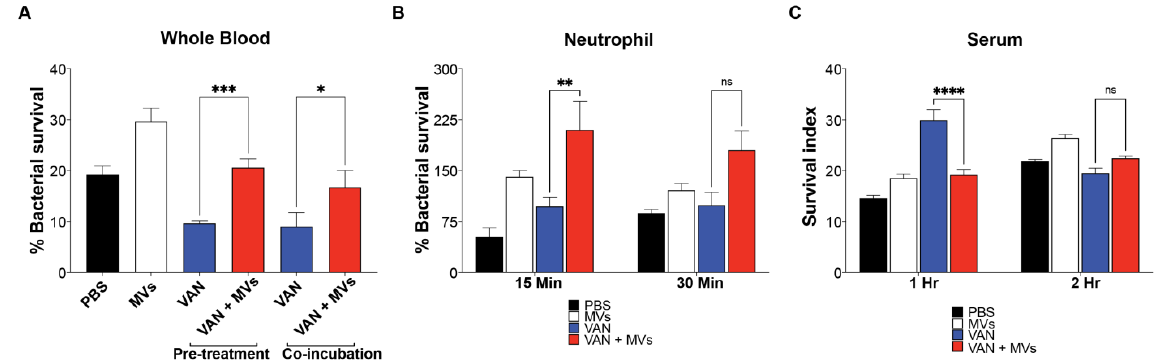
Figure 2. Ex vivo analysis of MRSA, VAN, MVs and components of host innate immunity. MRSA grown overnight or co-incubated with 0.5 mg/L of VAN are more resistant to killing by ( A ) human whole blood (3 h) and ( B ) isolated neutrophils (15 and 30 min) in the presence of MVs (20 µg). However, exogenous MVs did not significantly increase the killing of MRSA pre-treated overnight with 0.5 mg/L of VAN to ( C ) human serum complement (1 and 2 h). Data are representative of the mean ± SEM from a combination of three experiments performed in triplicate. * p < 0.05, ** p < 0.01, *** p < 0.001, **** p < 0.0001, or no statistical significance (ns) in VAN treated samples by two-way ANOVA. PBS: Phosphate-Buffered Saline; MVs: Membrane Vesicles; VAN: Vancomycin.